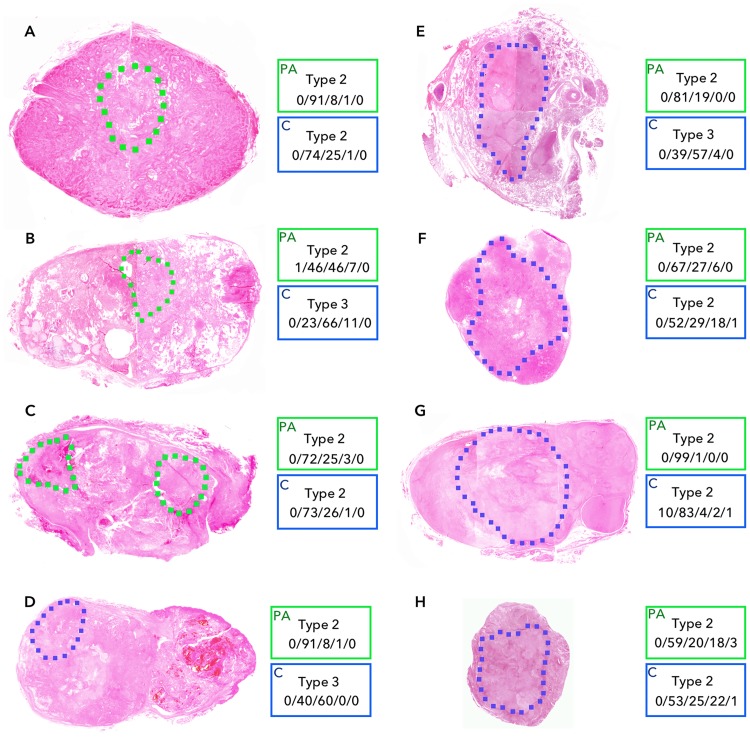
TIC profiles of pre-existing PA and malignant areas of 8 CXPAs.Overall TIC profile analysis and TIC mapping were performed separately in the pre-existing PA and malignant tumor areas in 8 CXPAs. Green and blue dashed lines on photomicrographs, respectively, indicate pre-existing PA and malignant tumor areas within CXPA tumor areas from 8 patients (A-H for patient no. 1–8 in the same order; see Table 2). Boxes directly right to the respective photomicrographs (H & E staining) show overall TIC profiles (upper panel in each box) and TIC mapping (lower panel in each box; % tumor areas as Type 1/Type 2/Type 3/Type 4/Type 5) of pre-existing PA (green, PA) and malignant tumor (blue, C) areas within CXPA tumors.